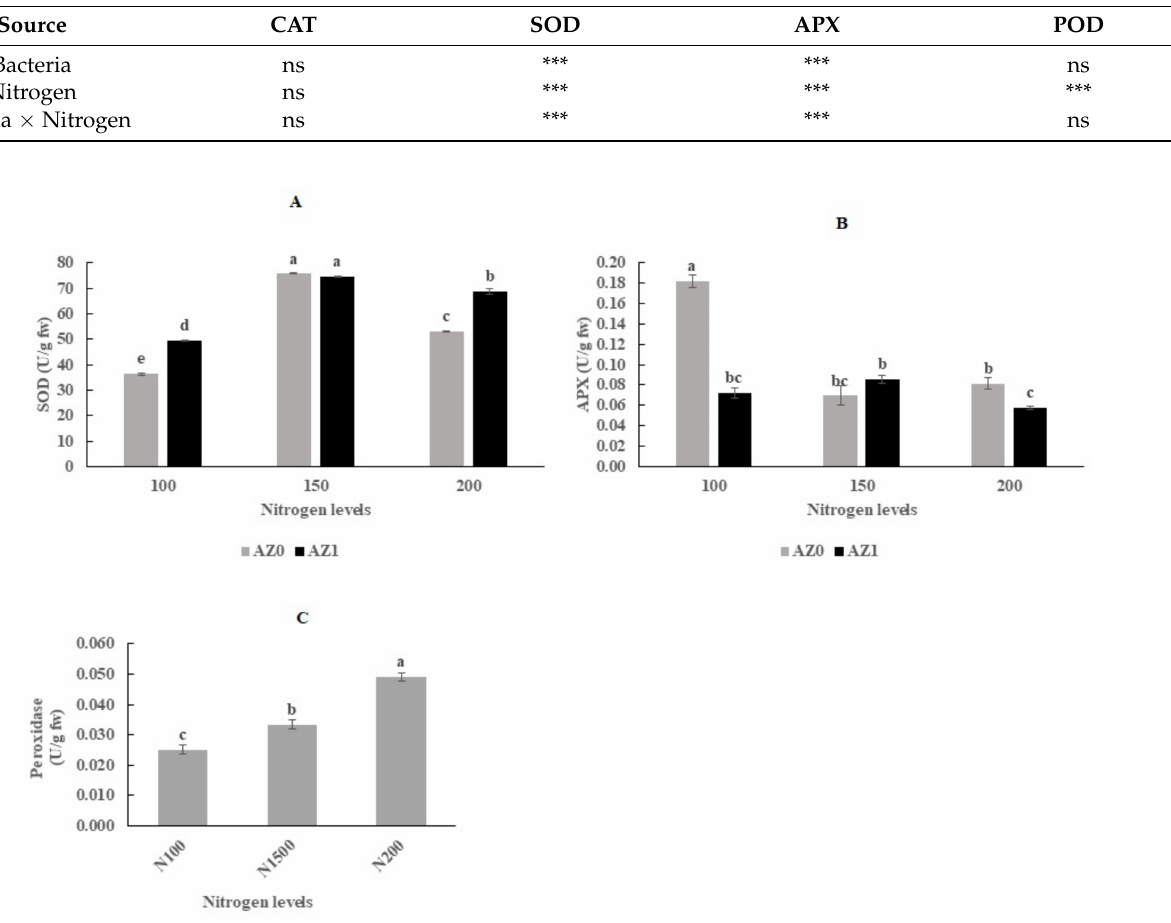
Figure 5. Antioxidant enzyme activity, SOD ( A ), APX ( B ) and POD ( C ) in hydroponically grown lettuce influenced by Azotobacter under different nitrogen levels. The letters indicate the mean comparison using LSD test ( p < 0.05) which was implemented for examining the differences among the